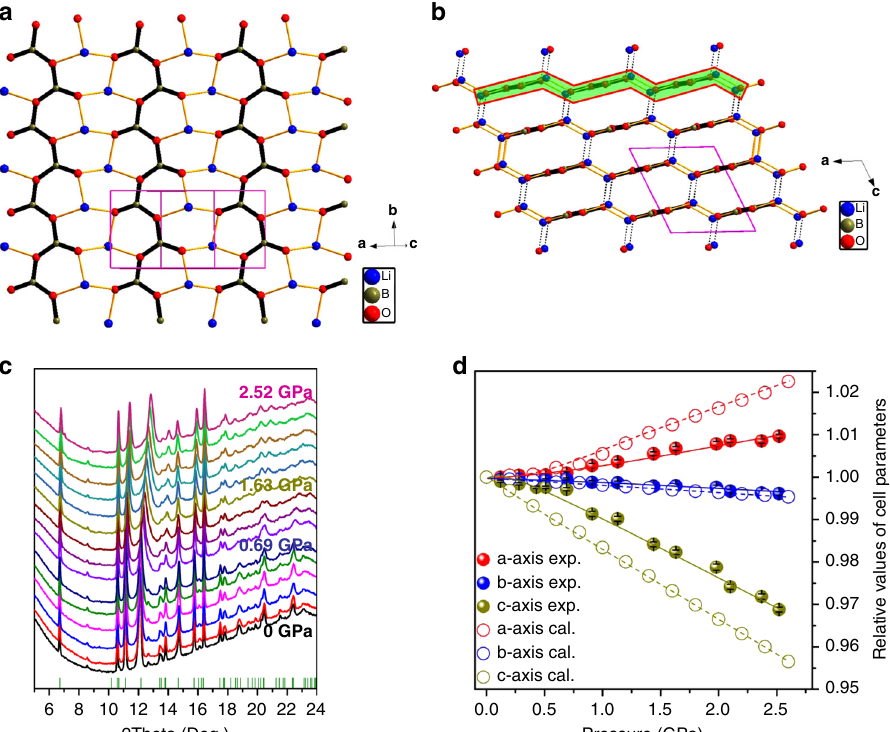
Fig. 1 Crystal structure and linear compressive behaviors in LiBO 2 . a Graphite-like [LiBO 2 ] ∞ layer (in the a-b plane), in which the [BO 2 ] ∞ belt is highlighted by thick bars in a zig-zag con fi guration. b Bond connection between the neighbor [LiBO 2 ] ∞ layers (along the c-axis), in which the corrugations introduced by (LiO 3 ) bases are highlighted by green strips. The unit cells are represented by pink boxes. c evolution of the high-pressure XRD patterns. d Variations of a -axis, b -axis, and c -axis with respect to hydrostatics pressure. Experimental and fi rst-principles results are represented by solid and open circles,